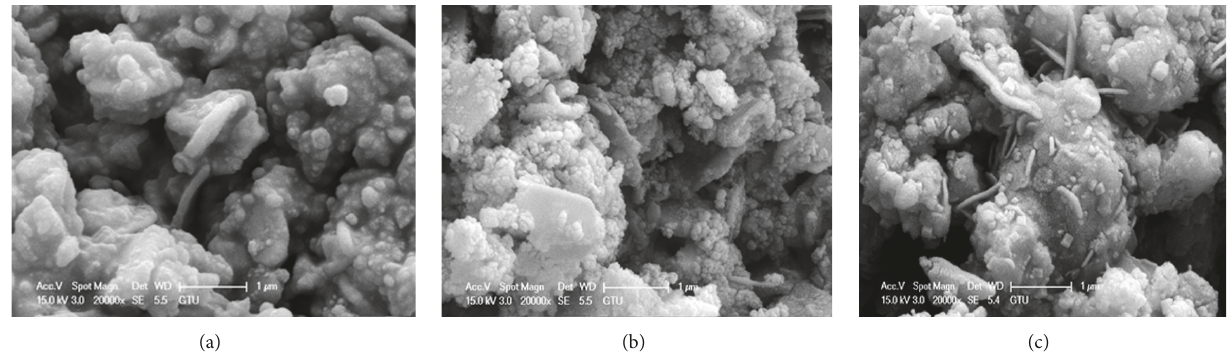
Figure 2: SEM micrographs of synthesized CIS powder at 240 ∘ C for (a) 10h, (b) 20 h, and (c) 40h with oleylamine solvent.